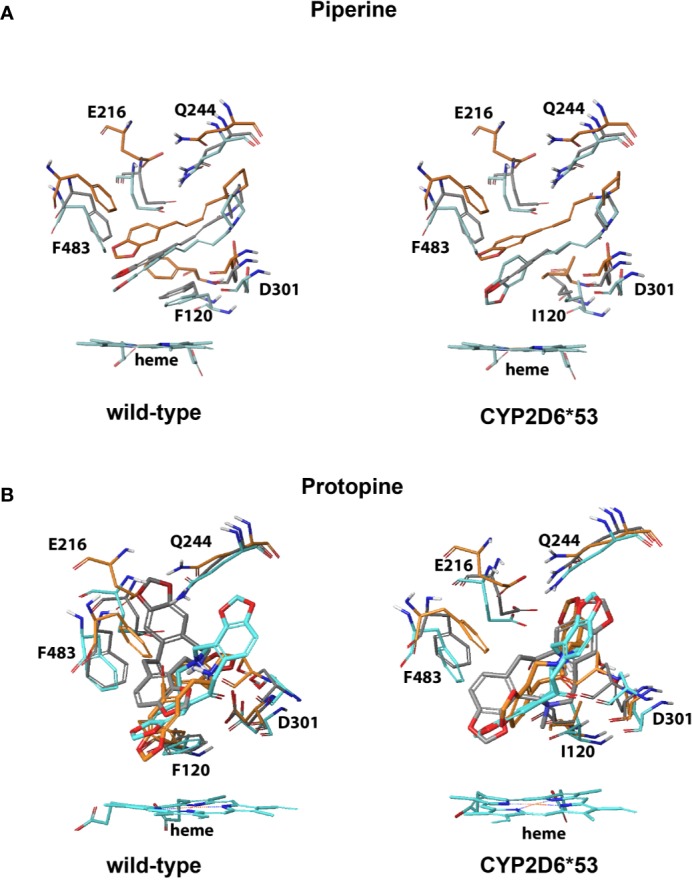
CYP2D6 WT and CYP2D6*53 inhibition binding modes for (A) piperine and (B) protopine. The best scored poses are shown docked into 4WNW (cyan), 4WNU (orange), and 4WNT (grey). To keep a clear overview, only the interacting residues are displayed and labeled and solely the heme of 4WNW is displayed.